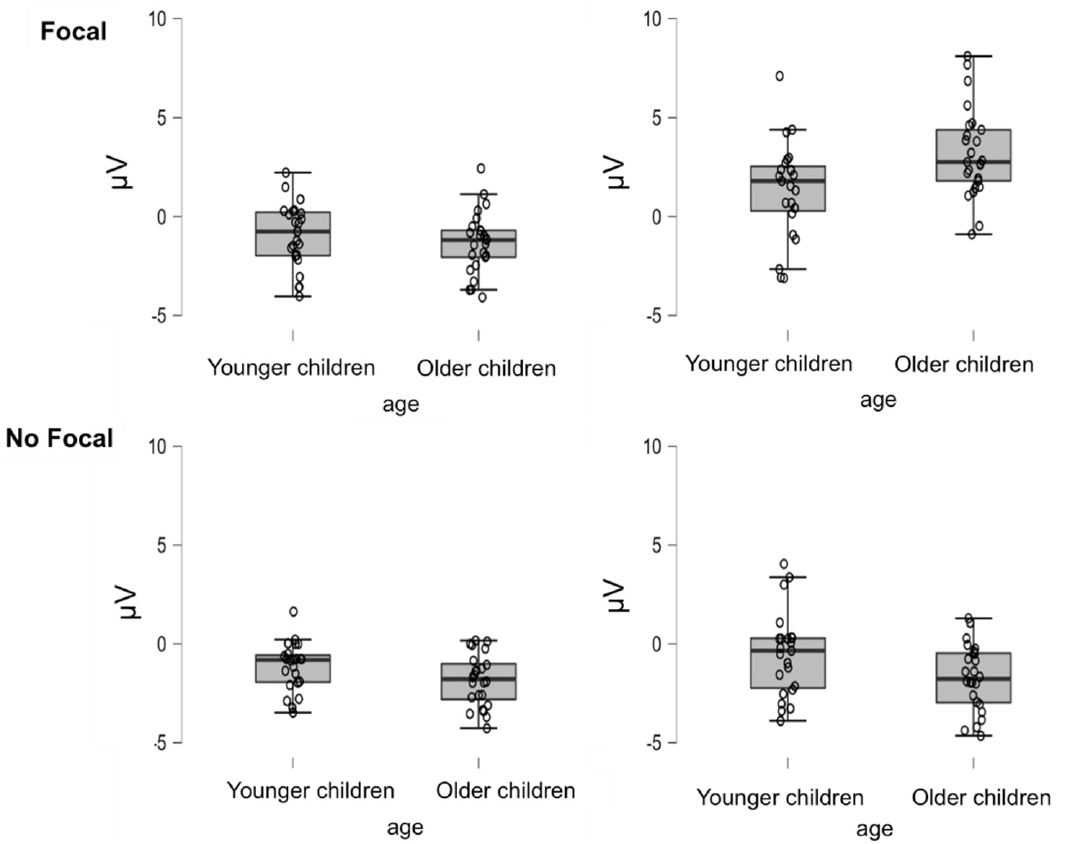
Figure 6. Box plots of the amplitude of the frontal positivity component as a function of age, focality and type of trial.